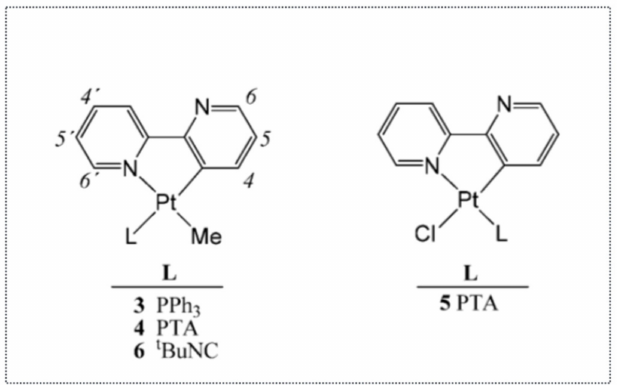
Figure 9. Platinum organometallic complexes inducing the ER stress